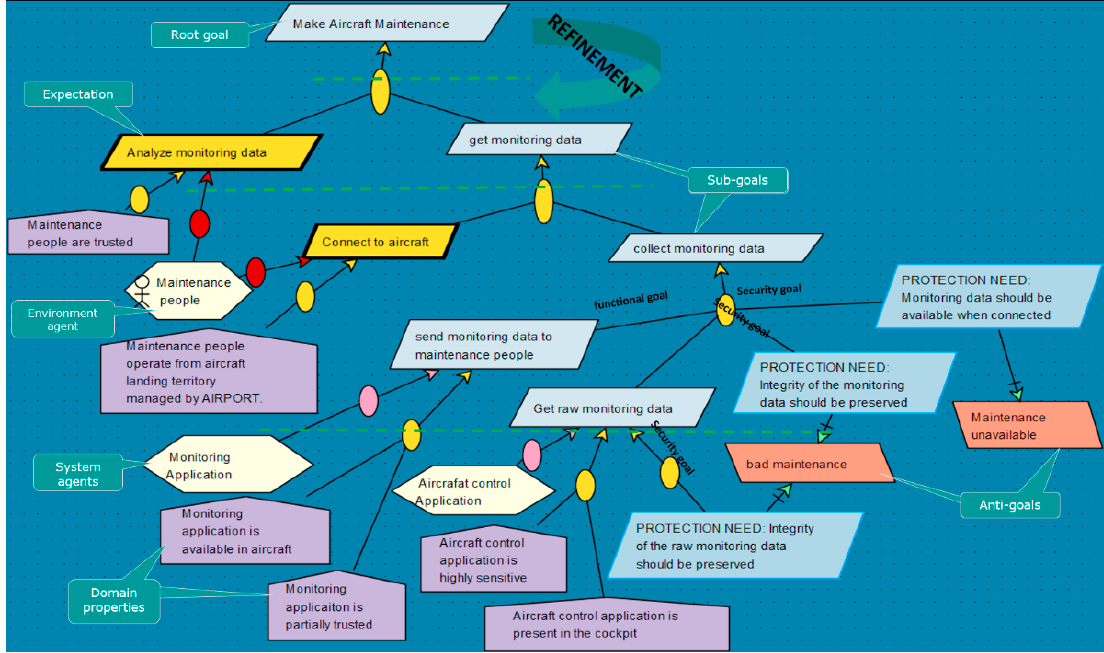
Figure 6. Secure KAOS goal specification (sample).